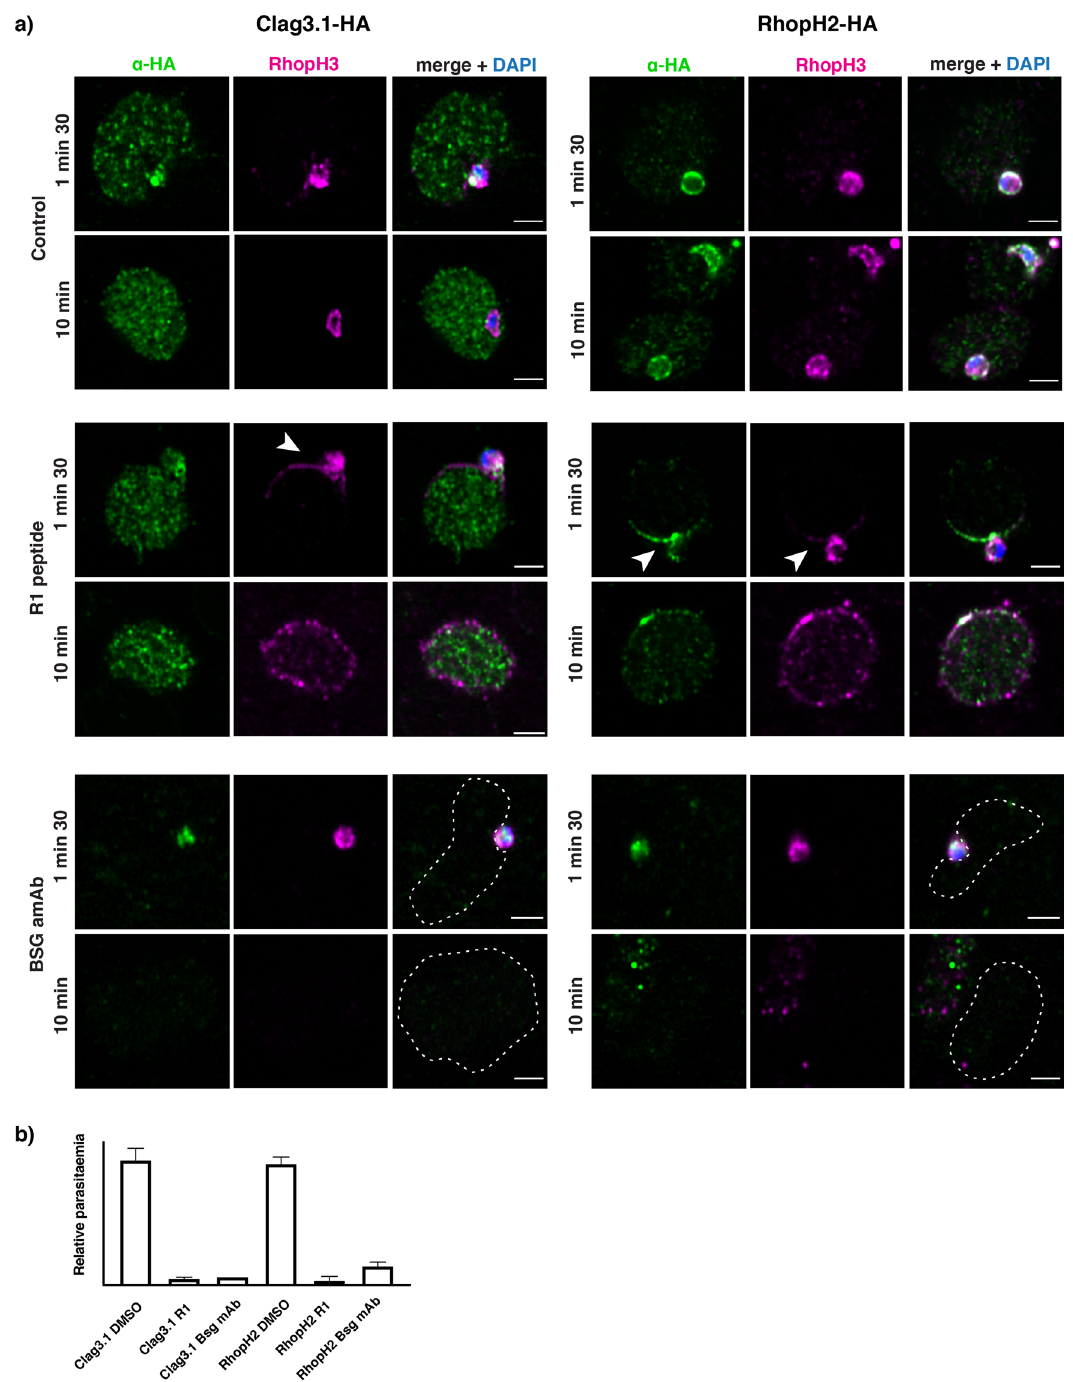
Fig. 3 RhopH proteins have different cellular localizations during invasion. a Super-resolution imaging of Clag3.1-HA, RhopH2-HA and RhopH3 (DMSO control). RhopH proteins in the presence of invasion inhibitors with DMSO control (top two panels), R1 peptide (middle two panels) and anti-BSG (bottom two panels). Arrows point to membrane localization of RhopH2 and RhopH3. A dashed line outlines the erythrocyte. Scale bar 2 µ m. b Invasion ef fi ciency in > 2000 cells per group from two independent experiments for each of the conditions. Error bars show